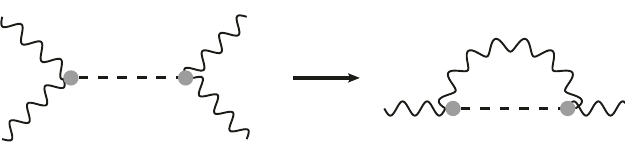
Figure 5 . π 0 -exchange contribution to the VP via Cottingham-like